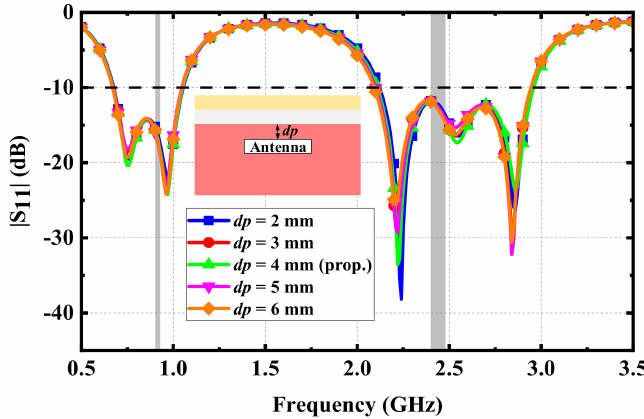
Figure 7. Simulated |S 11 | varying with the implanted